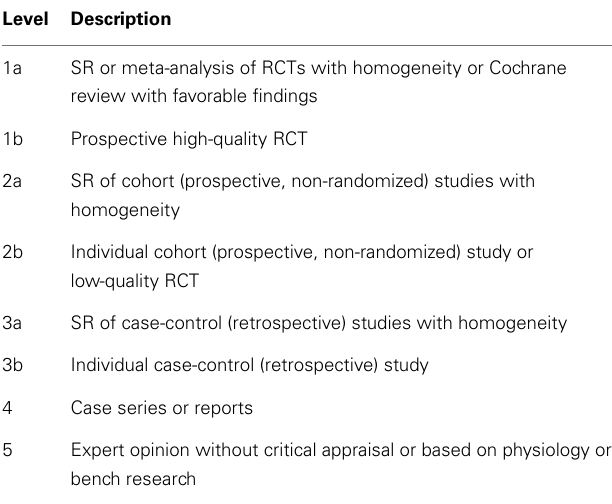
Table 1 | Levels of evidence.